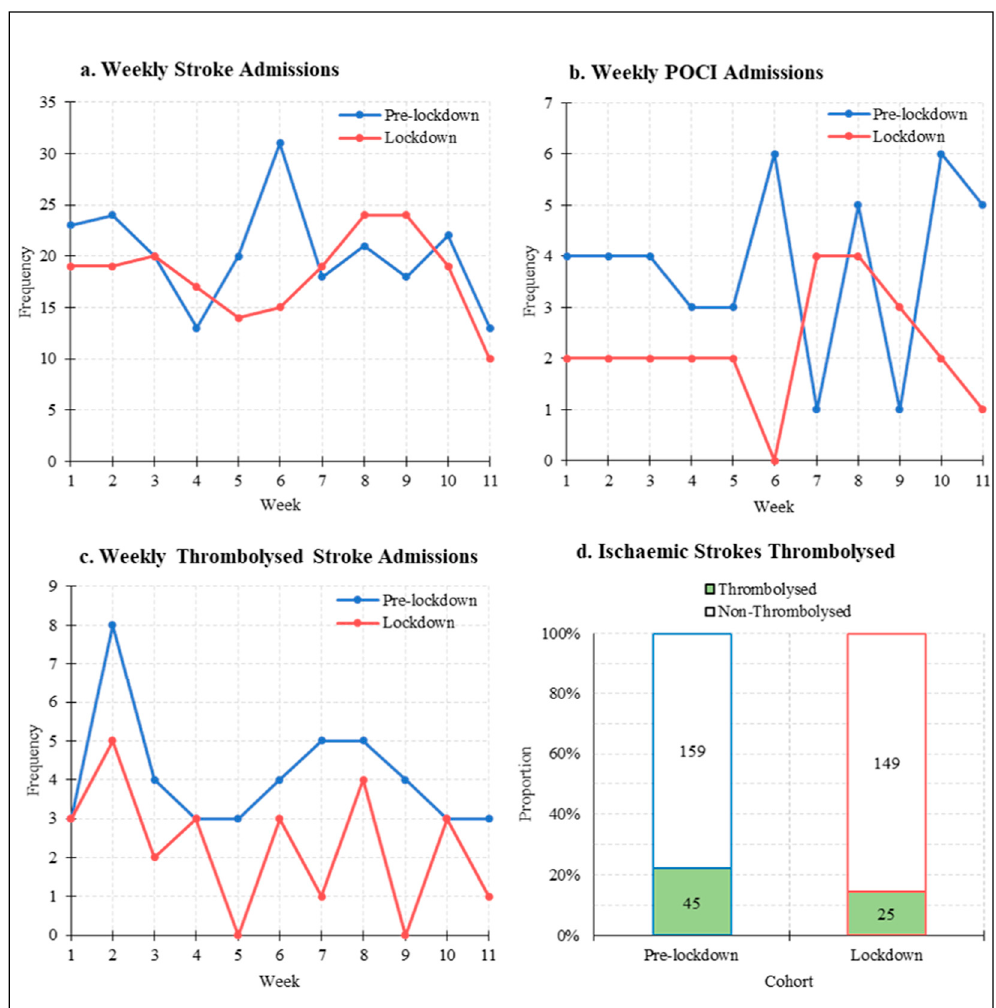
Figure 2. Stroke Admissions Trends in the Pre-lockdown and Lockdown Cohorts. Weekly ( a ) stroke, ( b ) POCI, ( c ) thrombolysed stroke admissions data in the pre-lockdown (blue) and lockdown (red) cohorts. Additional analysis of ischaemic stroke admissions ( d ) revealed no difference in the proportion of ischaemic strokes thrombolysed. POCI: posterior circulation infarct.